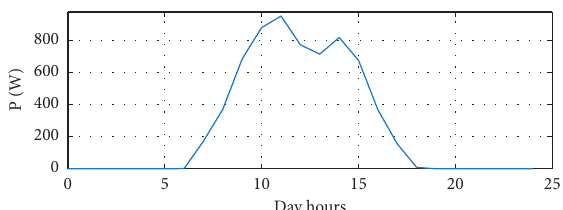
Figure 12: The assumed daily office load consumption (by 1